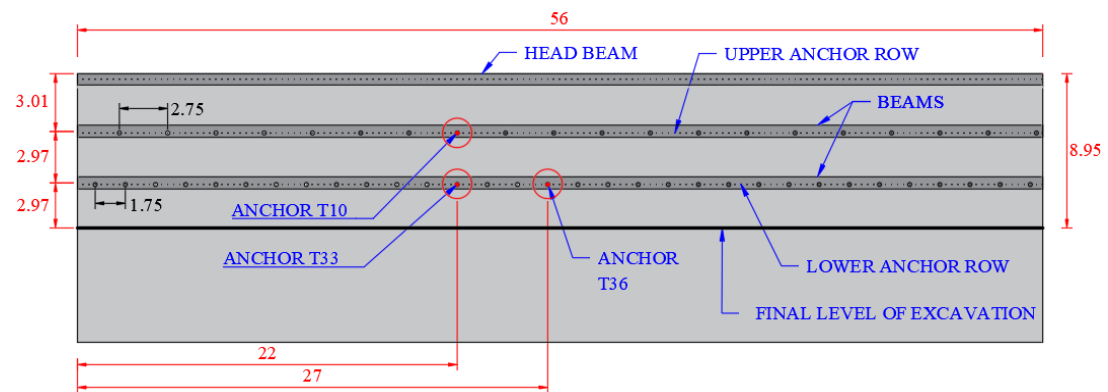
Figure 1 - Schematic showing front elevation view of the instrumented retaining wall (units: m).